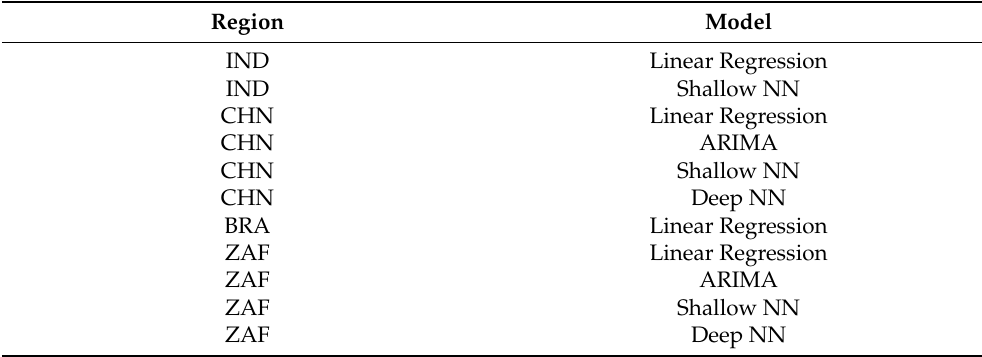
Table 6. Models that have exhibited overfitting (i.e., corresponding to a value that is greater than 10% in Table 5) under a polynomial degree of